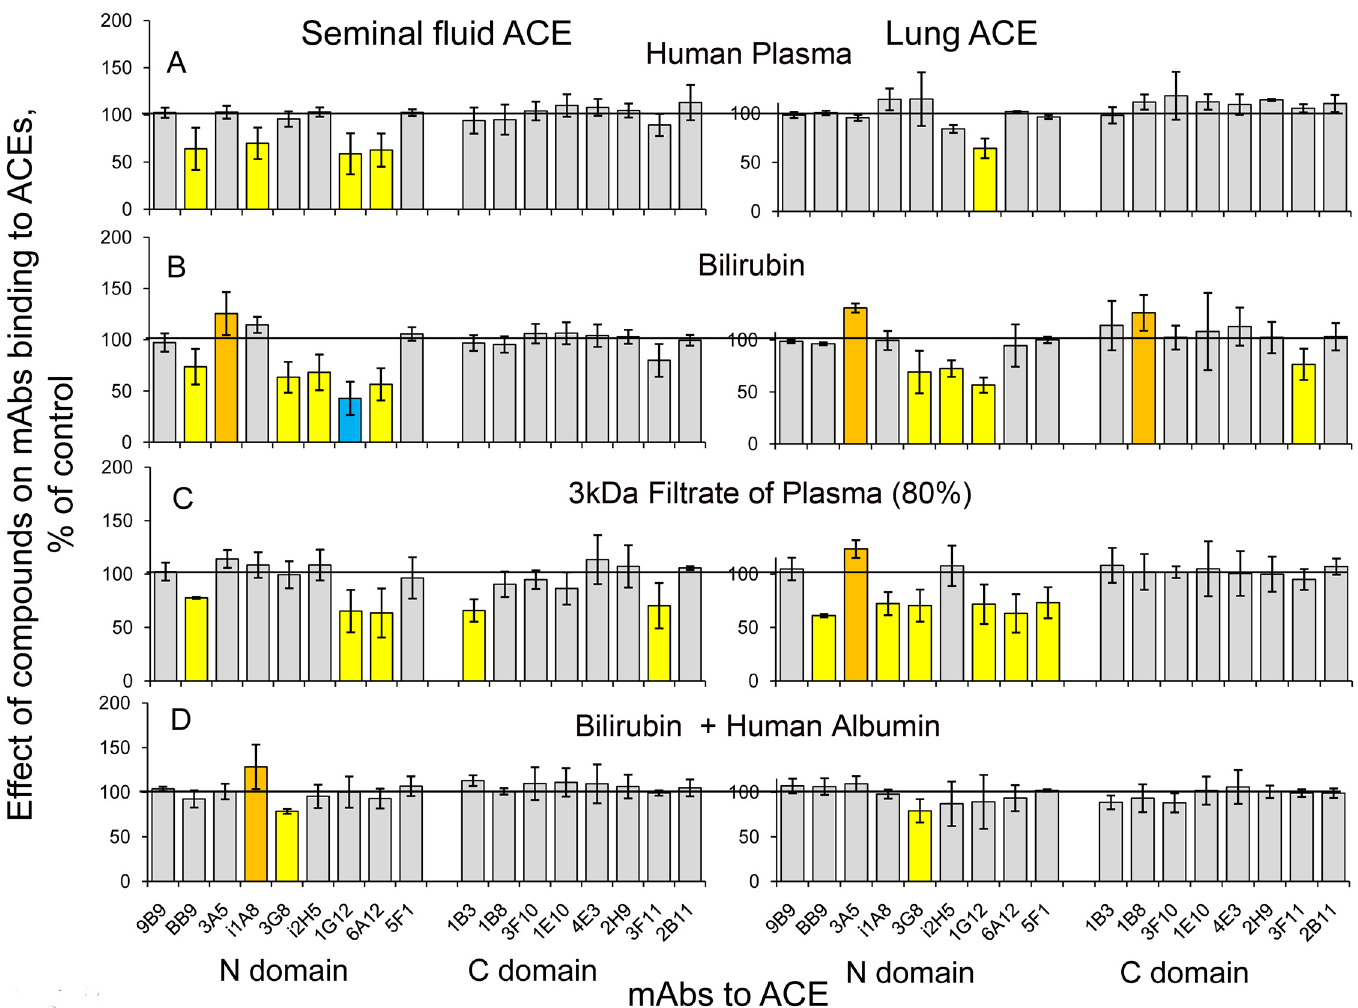
Fig 6. Effect of different additives on mAbs binding to seminal fluid and lung ACEs. ACE activity immunoprecipitated by 17 mAbs to ACE (as in Fig 1) was presented as a normalized value ( “ binding ratio ” ) to highlight differences in immunoprecipitation pattern ( “ conformational fingerprint ” ) after adding of tested compounds to purified seminal fluid and lung ACEs with that without additives. (A) Effect of 20% of human heat-inactivated plasma. (B ) Effect of 80% 3 kDa filtrate of human citrated plasma. C - D . Effect of bilirubin (150 ug/ml) in the absence ( C ) or presence ( D ) of human albumin at 8 mg/ml concentration (which correspond to its concentration in 20% serum). Data are presented as in Fig